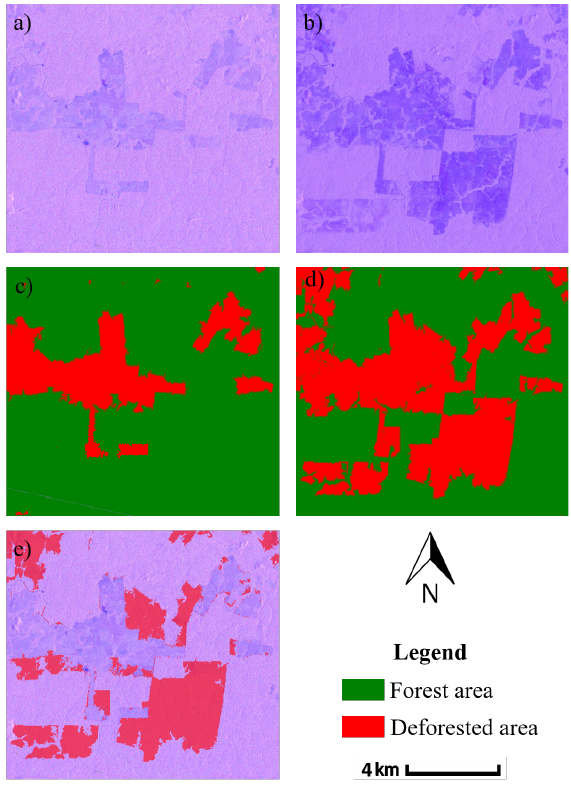
Figure 5. a) SE1 GRD composite (VH,VV and their difference) for 2015 with applied dry coefficient b) SE1 GRD